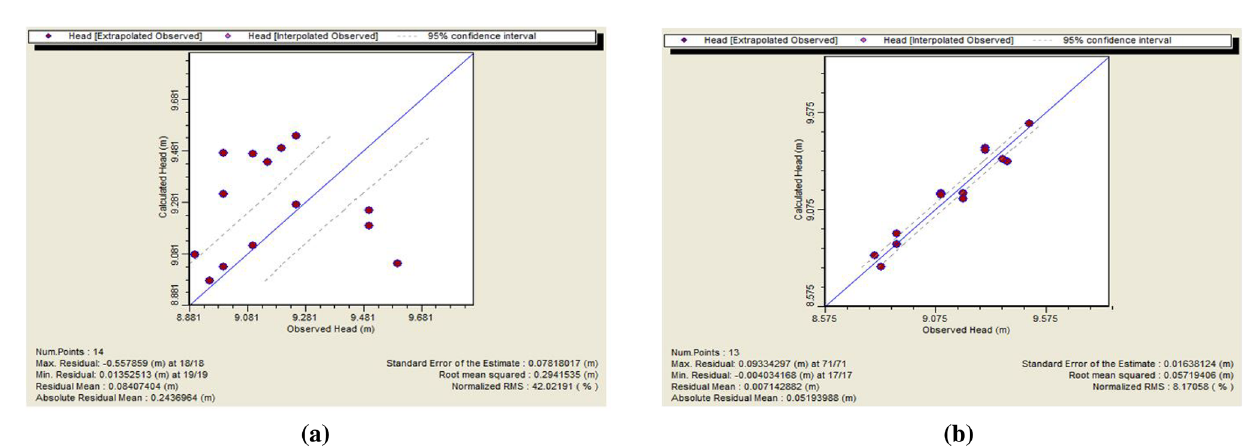
Fig. 6 Calculated head and the observed head for the steady-state condition a before calibration, b after